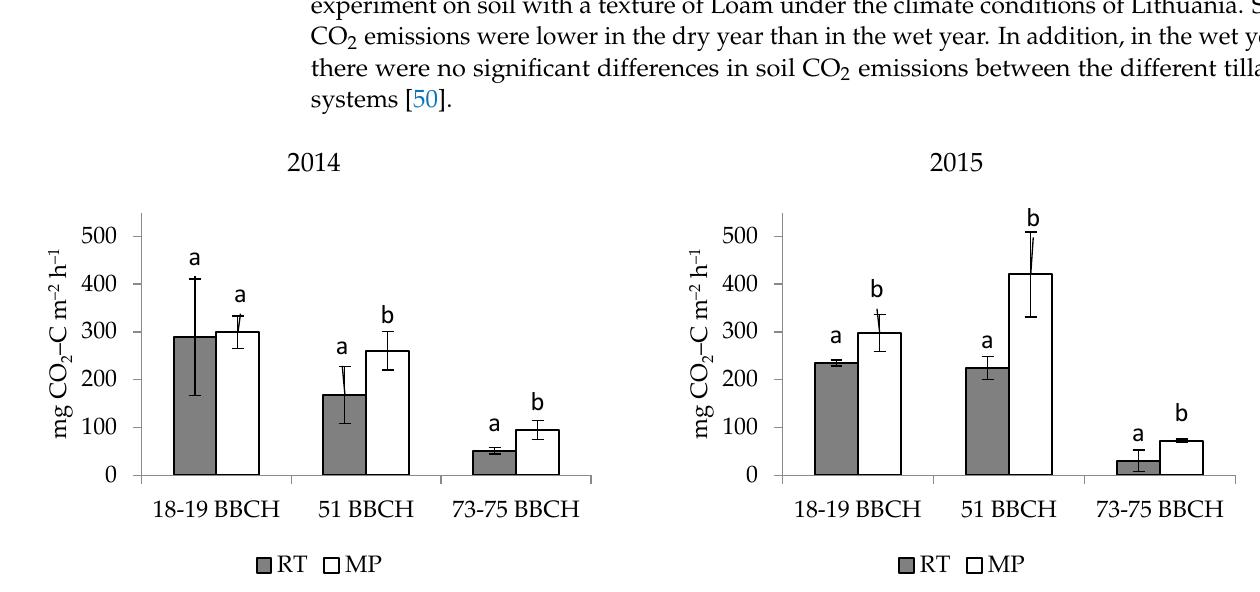
Figure 3. Soil CO 2 fluxes in RT and MP cropping systems in an optimal moisture year (2014) and a dry year (2015) in a short-term experiment in Babor ó wko (Western Poland). Different letters (a, b) indicate significant differences ( p < 0.05) among treatments (RT, and MP) (separately for test dates). Table 2. The average soil CO 2 flux (mg CO 2 -C m − 2 h − 1 ) during the growing season under the influence of different tillage systems, mineral fertilization methods, and permanent